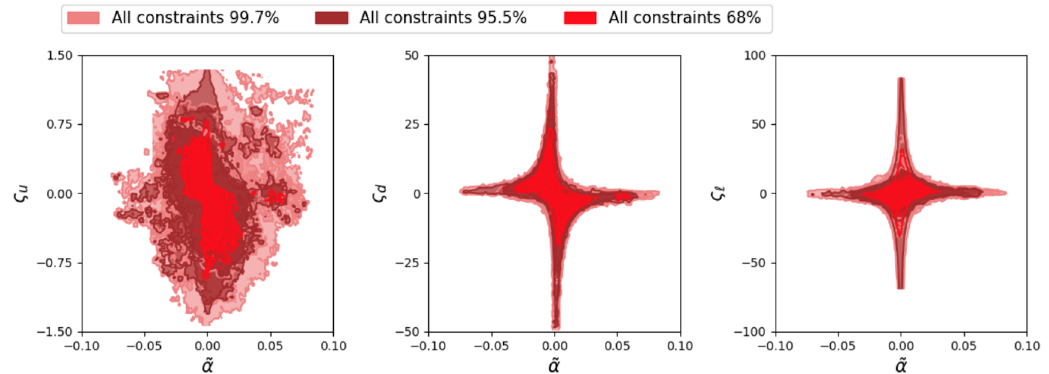
Figure 8. Constraints on the planes ς f − ˜ α from the global fit at a 68% (dark red), 95.5% (brown) and 99.7% (light red) probability. Only the “right-sign” solution is